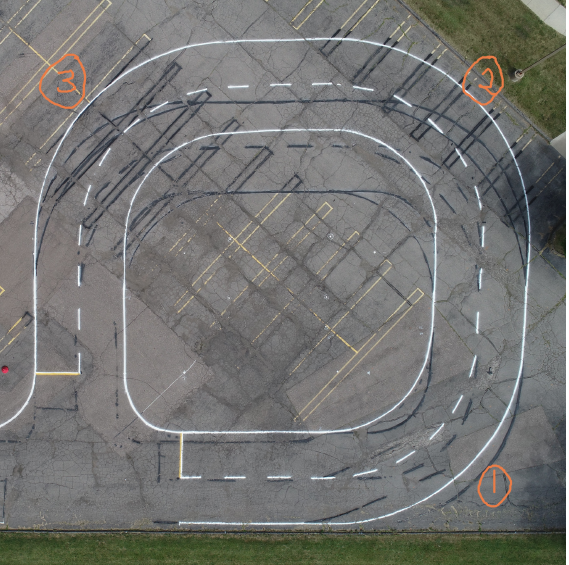
Figure 26. The nomenclature for the Turn Number is indicated in the above image. Table 4. Table indicating the most difficult turn for each algorithm. Parameter